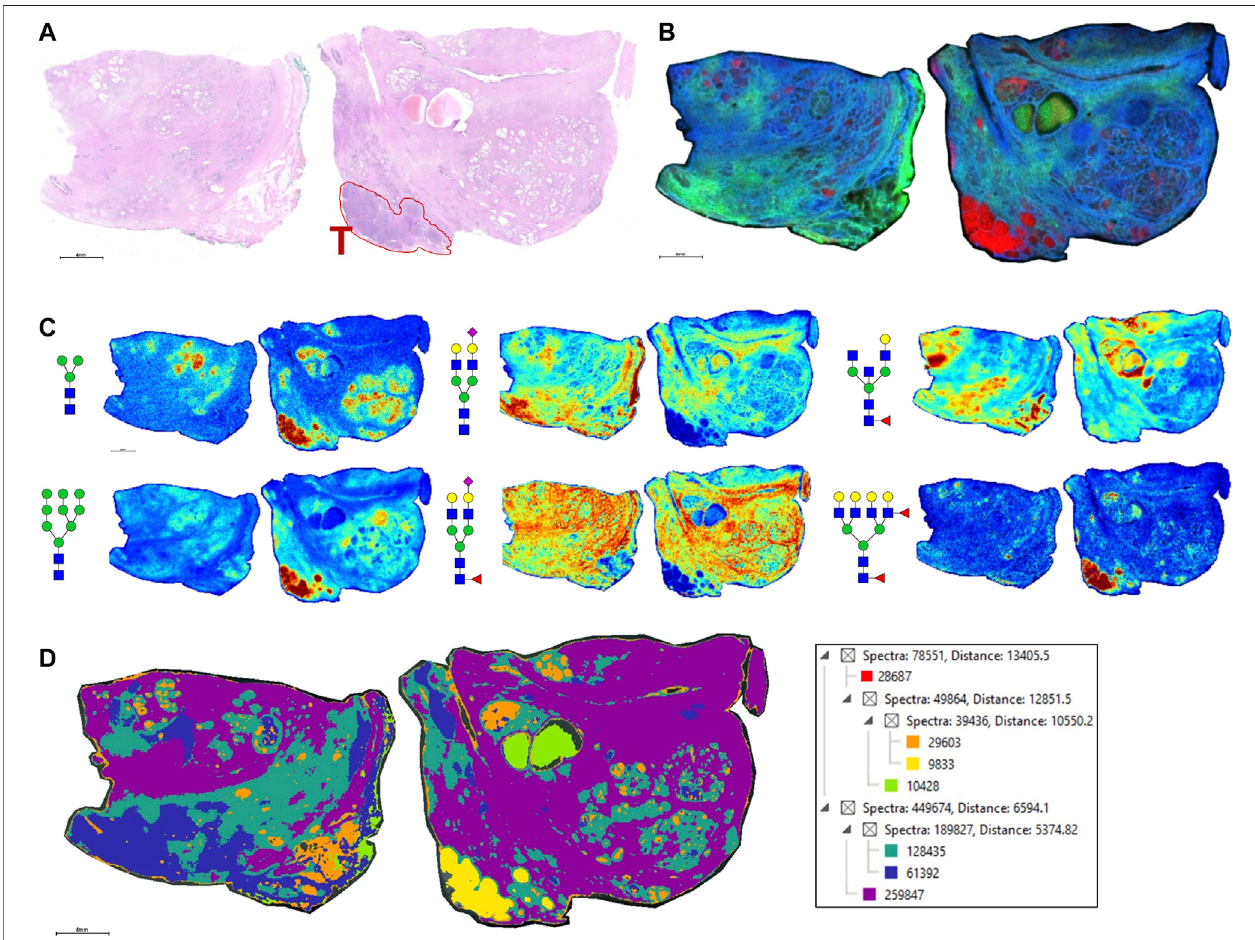
FIGURE5| N-glycanimagingofFFPEprostatecancerandnon-cancertissues. (A) H&Estainofthetwotissuesfromthesamedonor,non-cancertissueontheleft side and tumor on the right side. The tumor region, a Gleason grade 8/stage p3Tb, is highlighted with red outline and a red T. (B) An overlay MALDI image of three N-glycans, two stroma-associated ones, Hex5HexNAc4NeuAc1 in blue and Hex5HexNAc4Fuc1NeuAc1, and a tumor glycan Hex7HexNAc6Fuc2 (in red). (C) Six representative individual N-glycan images representative of different structural classes are shown, and glycan structure: a paucimannose (Hex3HecNAc2), high mannose (Hex5-Hex9HexNAc2), sialylated biantennary no fucose (Hex5HexNAc4NeuAc1), sialylated biantennary with fucose (Hex5HexNAc4Fuc1NeuAc1), bisecting GlcNAc biantennary (Hex4HexNAc4Fuc1) and branched fucosylated species (Hex7HexNAc6Fuc2). (D) Segmentation analysis, using Manhattan and k-bisecting classi fi cations, was applied to the 73 N-glycans detected in the tissues. Spectra groupings are shown in the adjacent data tree. The N-glycan compositions are represented by blue squares for N -acetylglucosamine, green circles for mannose, yellow circles for galactose, purple diamonds for sialic acid, red triangles for fucose, and an “ S ” for